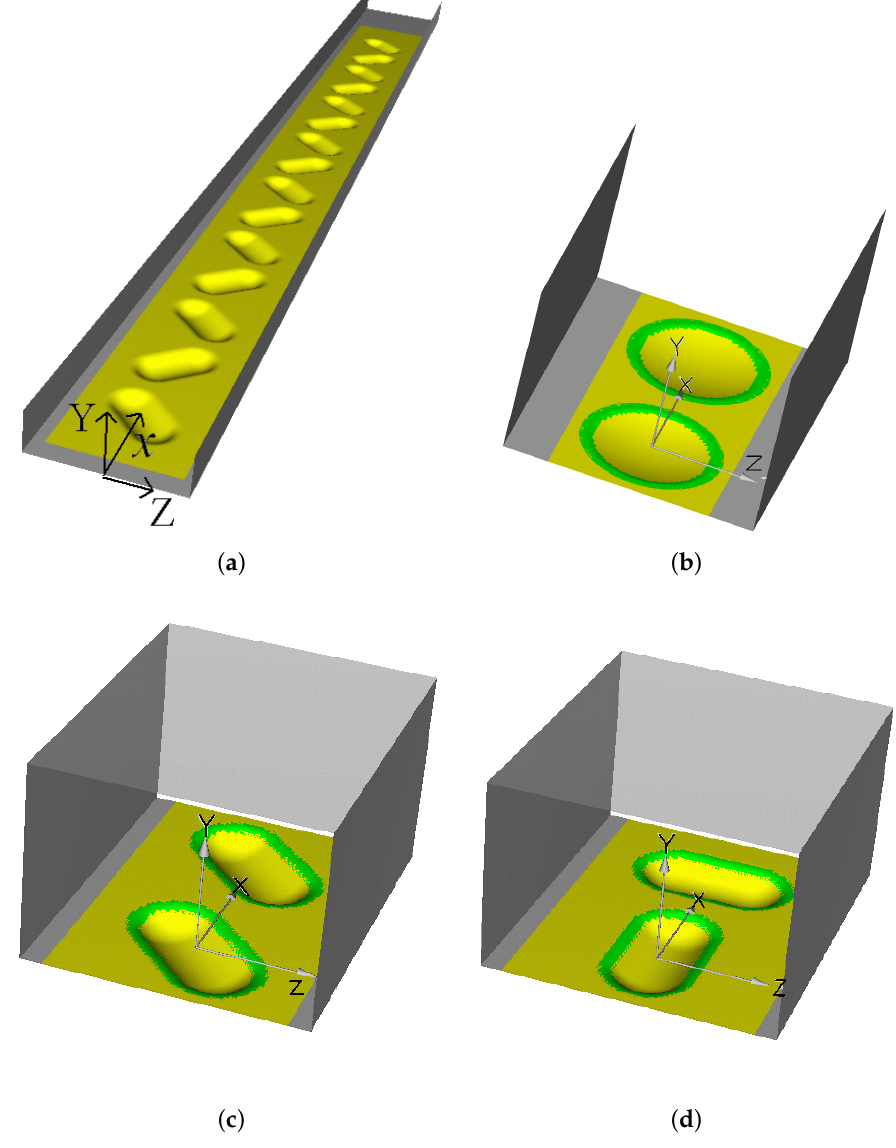
Figure 1. A long channel ( a ) with the 15 zigzag oval dimples applied to the bottom wall (with the top wall removed) and periodic sections of the channel with two spherical ( b ) and two oval dimples when they are arranged as a ladder at an angle of 45 ◦ ( c ) and longitudinal-transverse placement ( d